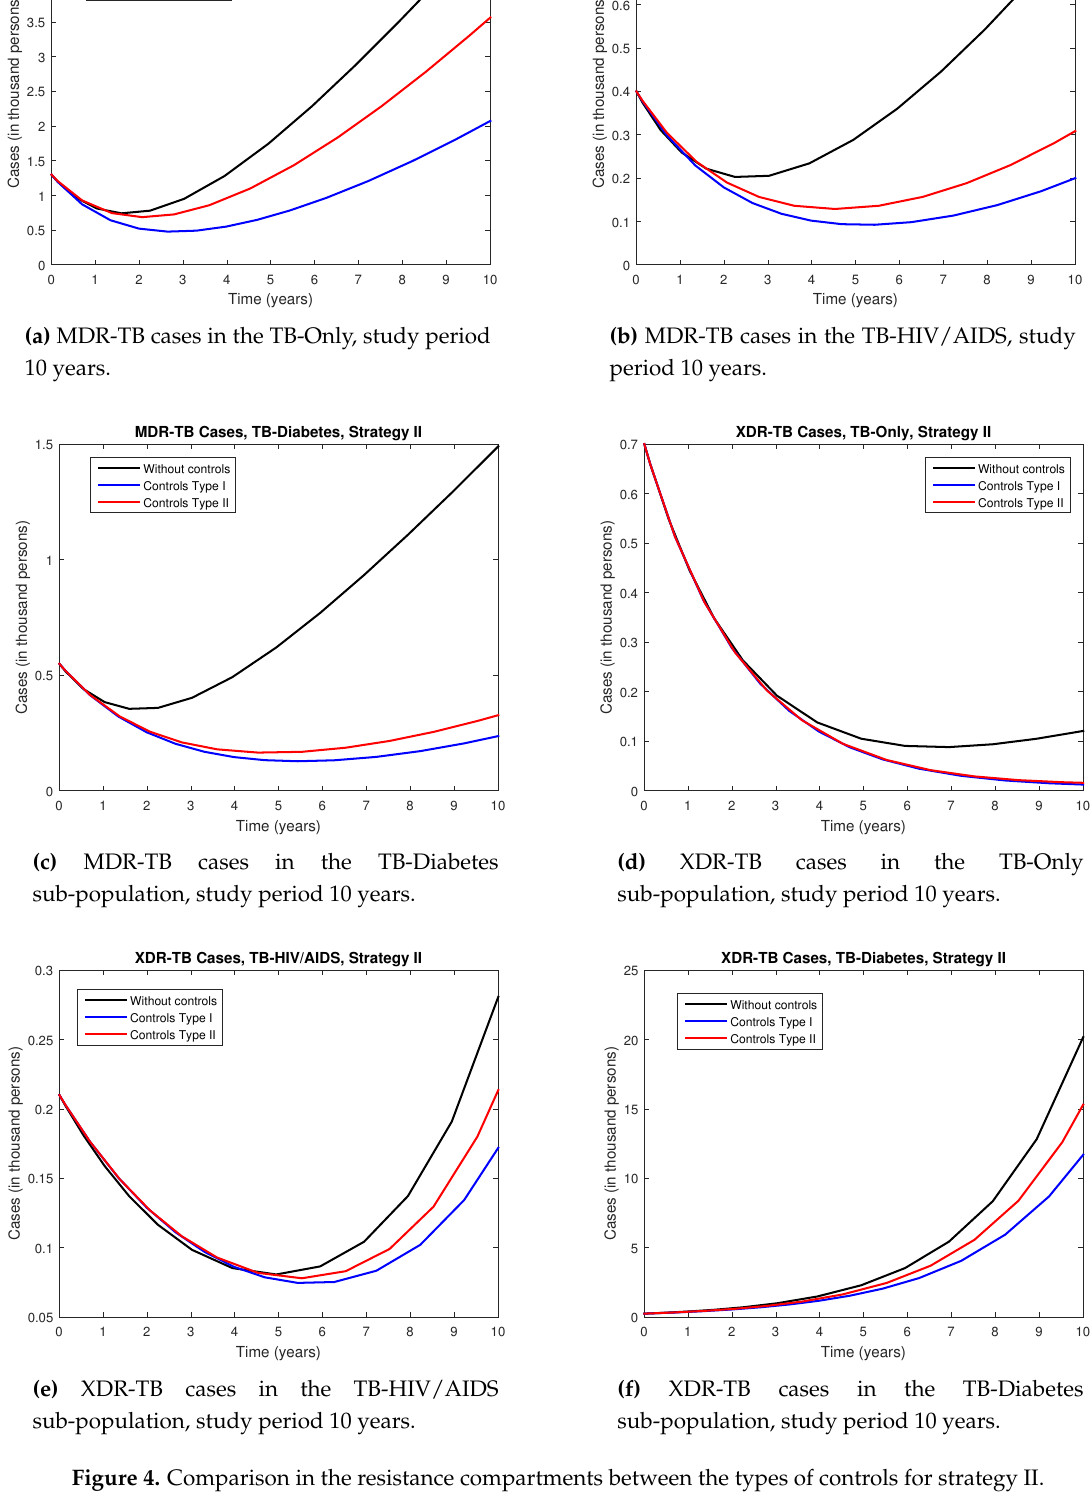
Figure 4. Comparison in the resistance compartments between the types of controls for strategy